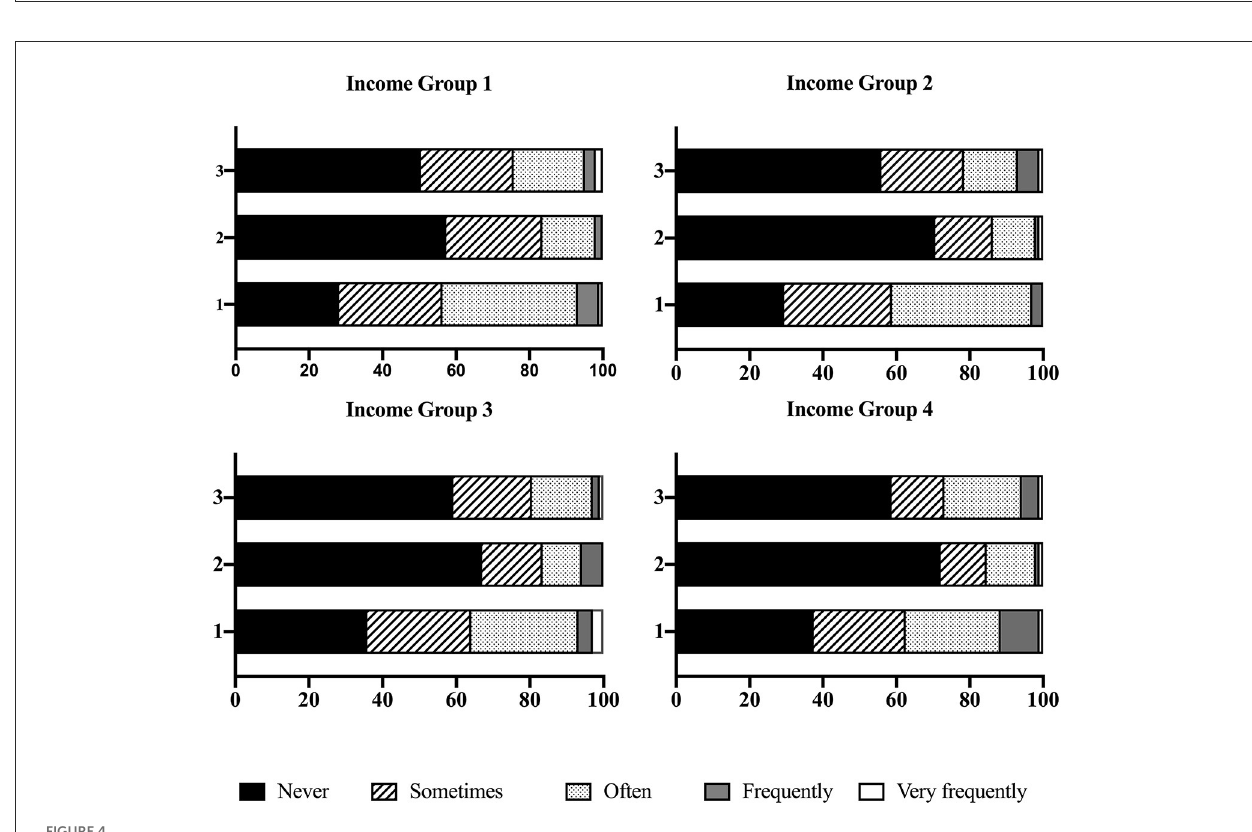
FIGURE4 History of adverse childhood experiences